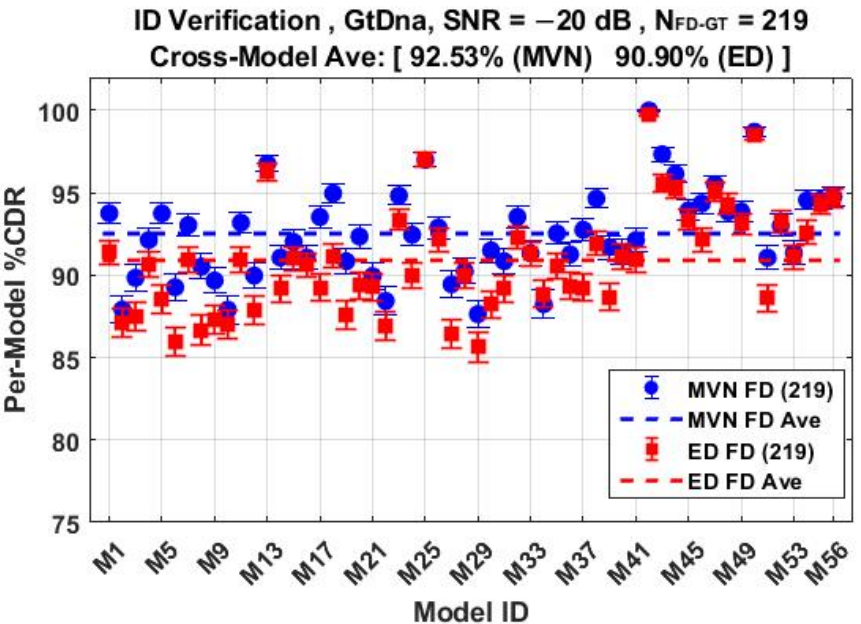
Figure 16. Per-model ID verification performance for full-dimensional N FD-GT = 219 features using the N Mdl = 56 MDA models used for generating %C results in Figure 12. Results generated under SNR = − 20 dB conditions using ED ( ■ ) and MVN ( ● ) measures of similarity.